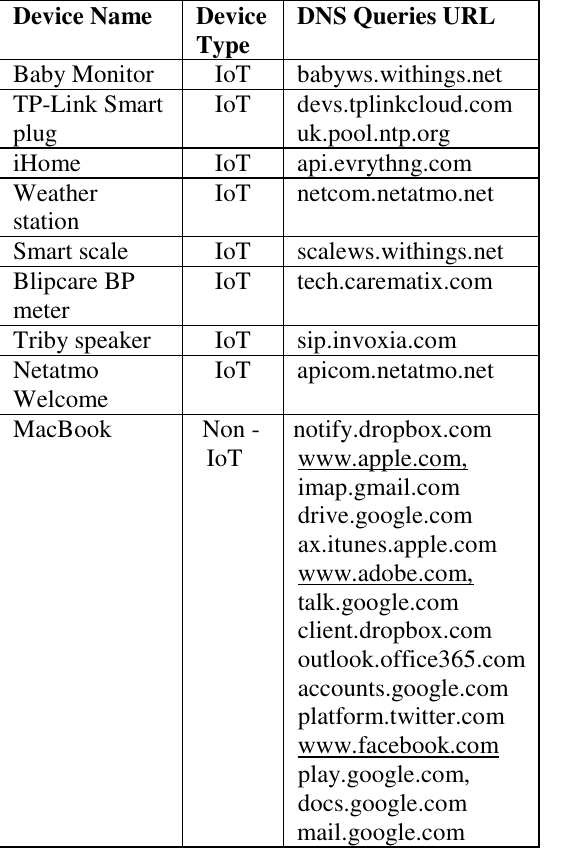
Table 3: DNS Server Summary of Devices Device